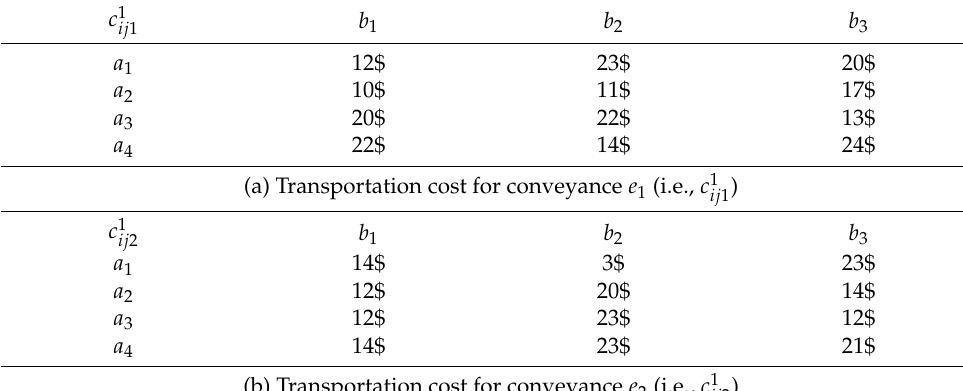
Table 2a,b present the transportation costs c 1 tively. Table 3a,b present the transportation costs c 2 tively.